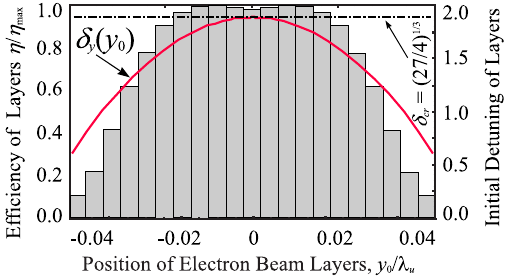
FIG. 6. The relative efficiency (histogram) and the initial de- tuning (red solid line) of electron beam layers vs the normalized transverse displacement of layers from the symmetry plane y ¼ 0